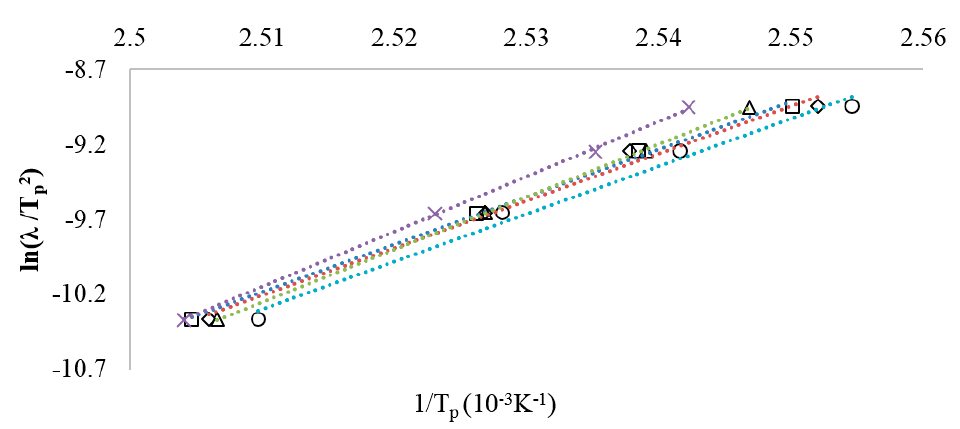
Figure 5. Plot of ln ( λ / T p 2 ) against 1/ T p for obtaining Δ E based on Kissinger method. Table 6. Effective activation energy calculated based on the Kissinger method.